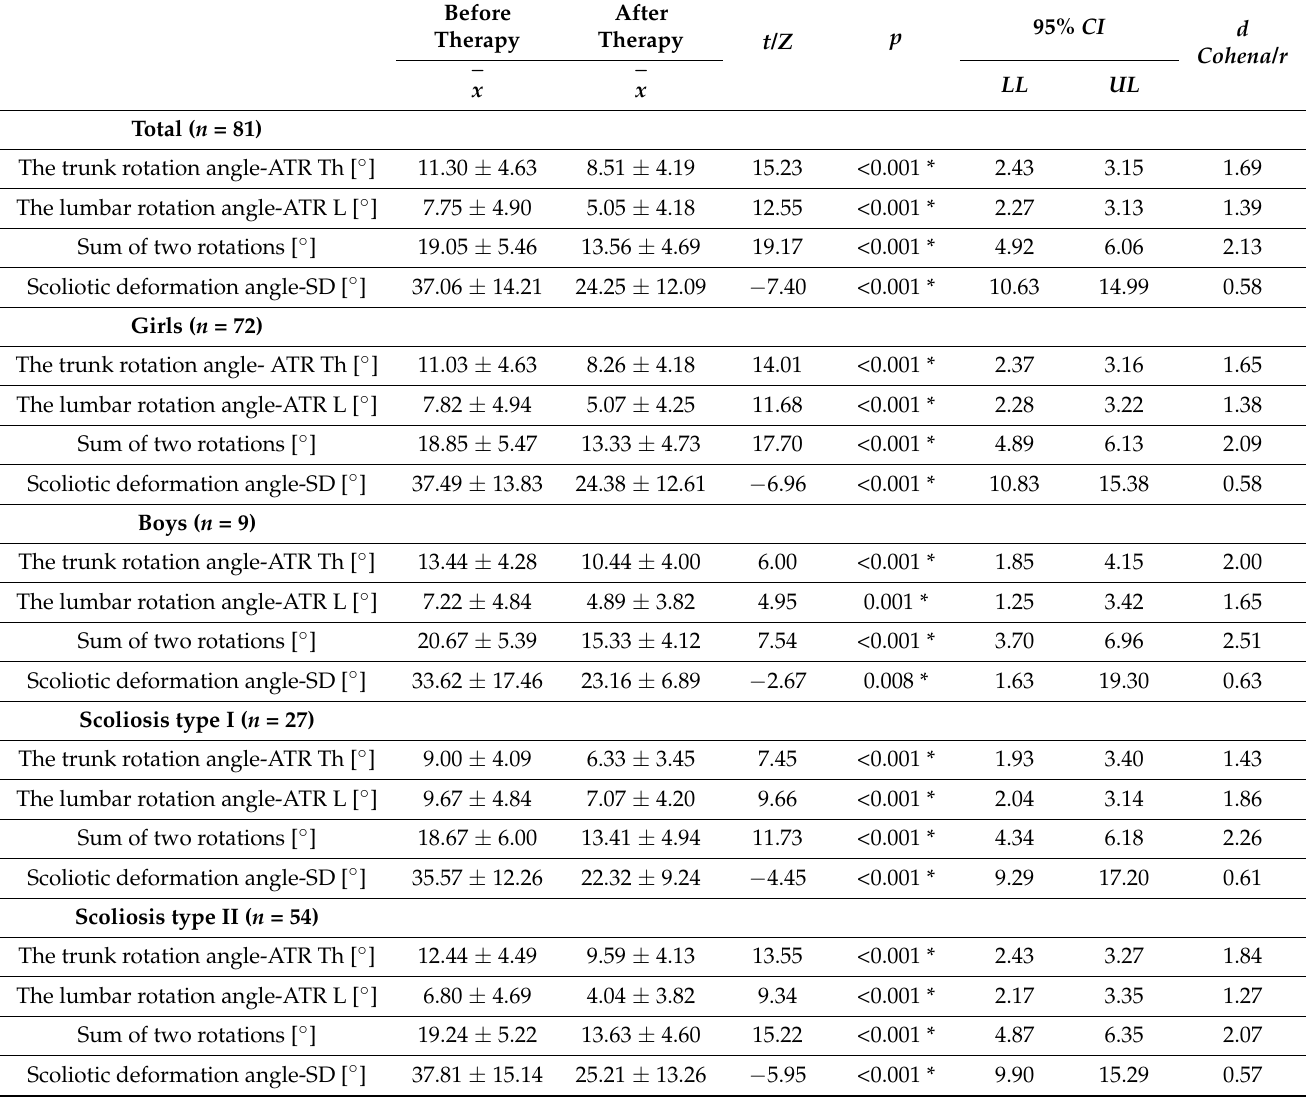
Table 4. Results of Student’s t -test for dependent samples and Wilcoxon’s test comparing individual parameters measured with a scoliometer and Zebris, before and after